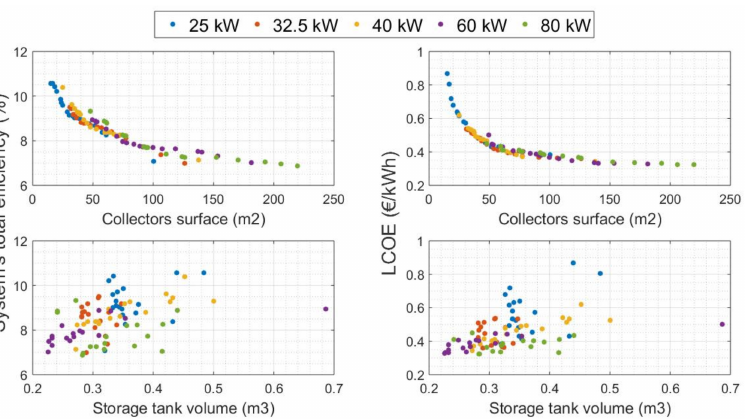
Figure 10. Variation of the optimized total solar conversion efficiency and levelized cost of electricity as a function of the solar collectors’ surface and storage tank volume for PTC-driven ORCs of different nominal heat input values located in Athens and operating with